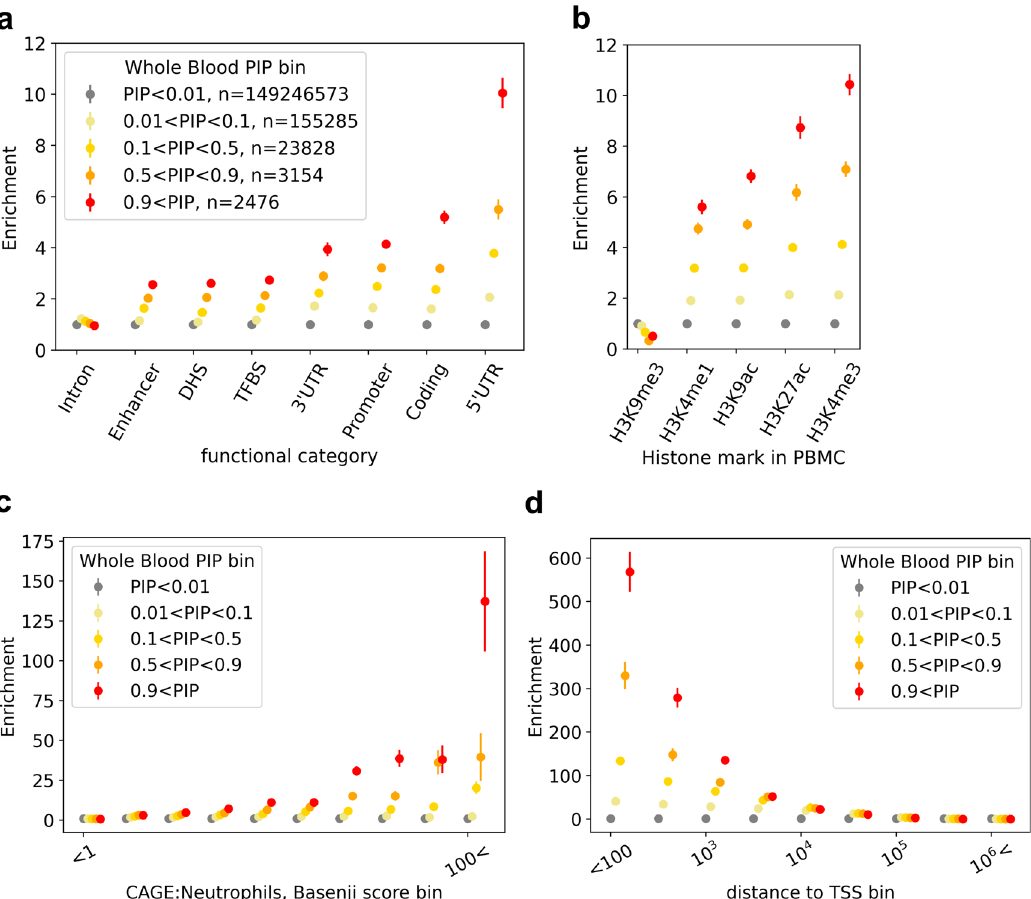
Fig. 1 Examples of the enrichment of variant – gene pairs in whole-blood eQTL PIP bins for functional genomics features. Enrichments of variant – gene pairs in different posterior inclusion probability (PIP) bins in binary functional features (non-tissue speci fi c ( a ), tissue-speci fi c in peripheral blood mononuclear cells ( b ), deep learning-derived regulatory activity (CAGE 46 ) prediction in neutrophils ( c ), and distance to TSS ( d ) are shown ( n is the number of variant – gene